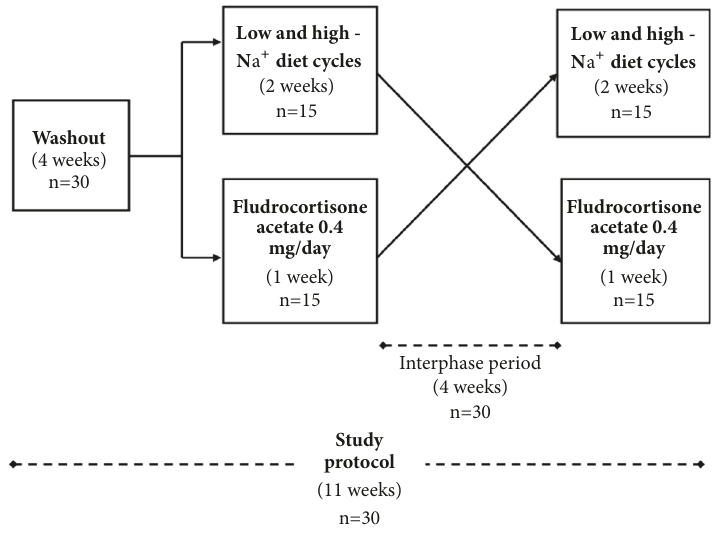
Figure 1: Study randomized crossover design. Na + =